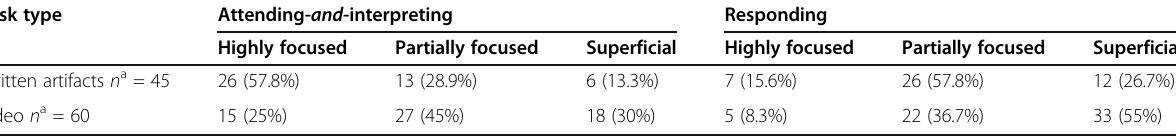
Table 1 Summary of attending-and-interpreting and responding practices in the context of video and written artifacts tasks Task